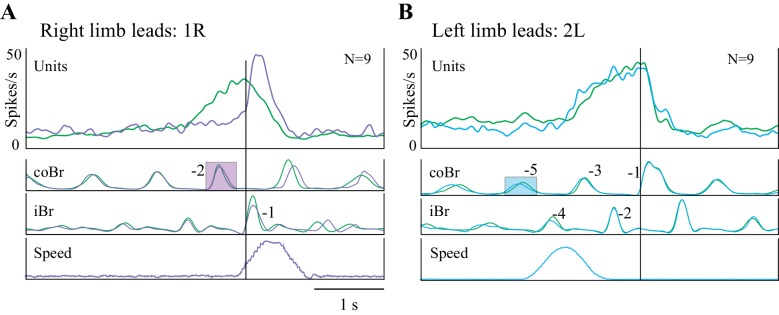
Population averages during acceleration task.(A) 1R condition. (B) 2L condition. Data are organized as for Figure 9.